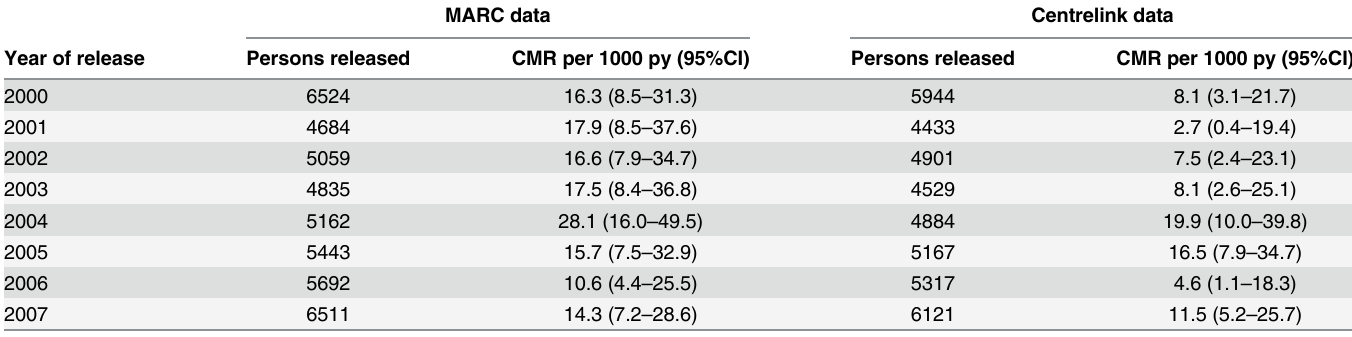
Table 1. Estimated number of releases and crude mortality rate within 28 days of release, among adults released from prison in Queensland 2000 – 2007, according to data source.